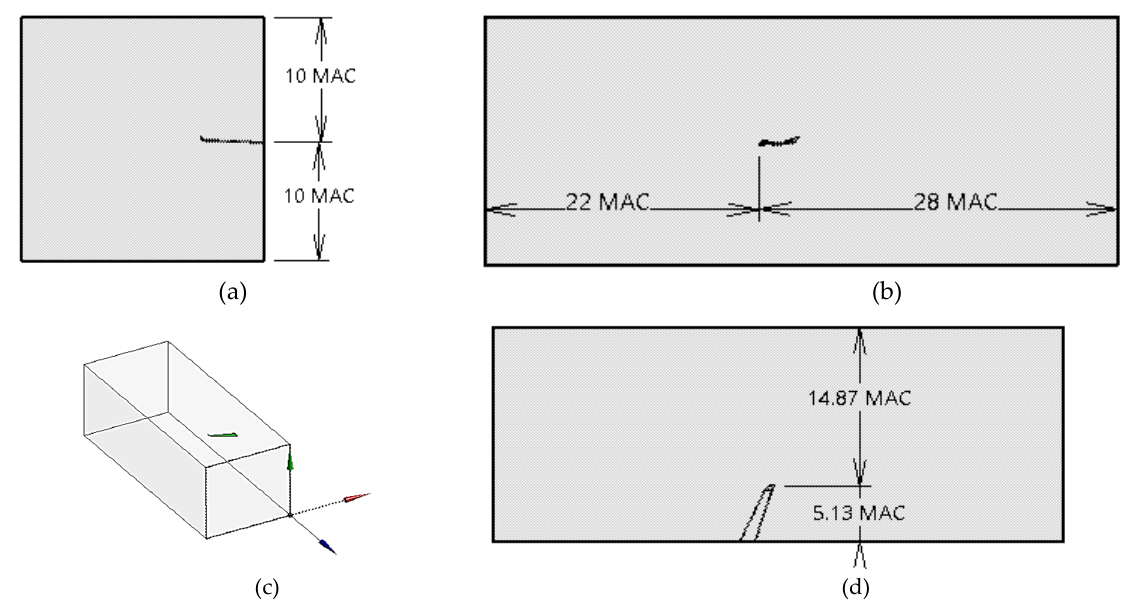
Figure 4. Computational Domain ( a ) Front view ( b ) Left side view ( c ) Perspective view ( d ) Top view.